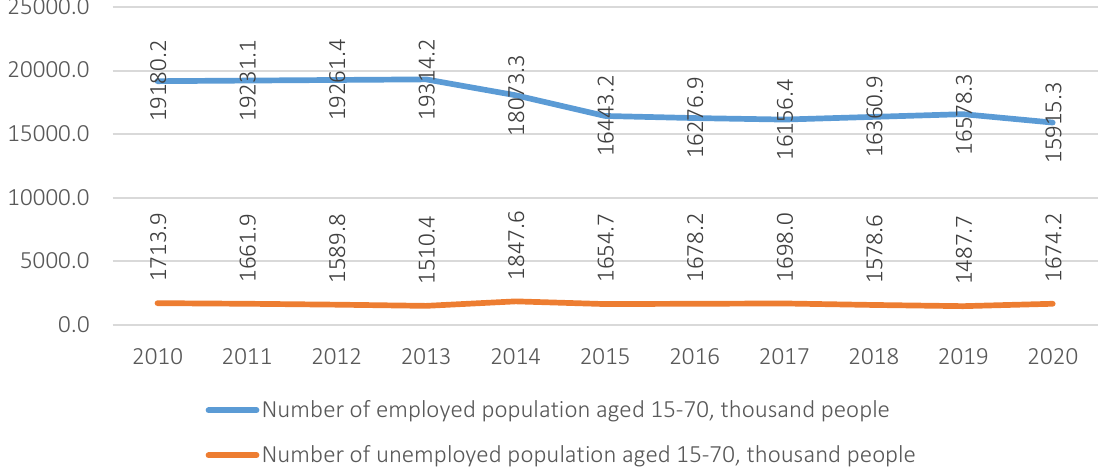
Figure 3. The number of employed and unemployed population in Ukraine in 2010–2020